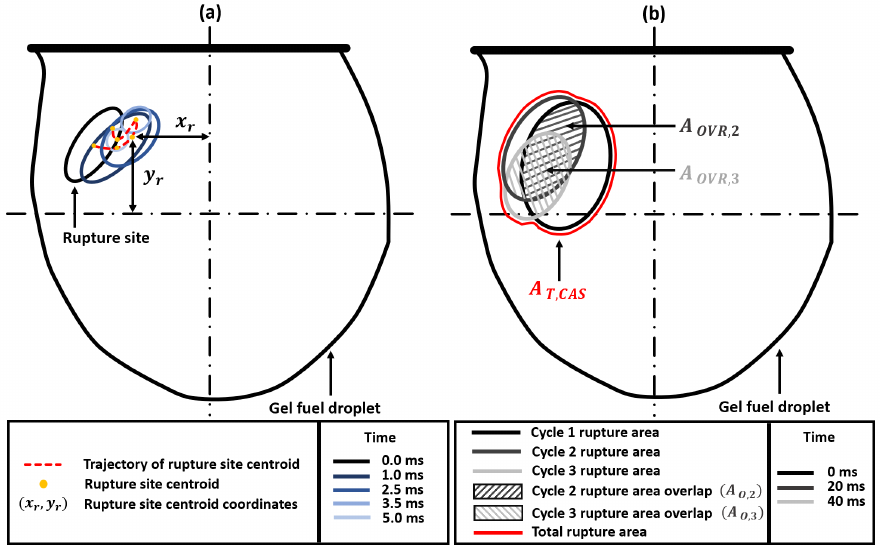
Figure 4. Schematic diagram showing the key geometrical parameters for analyzing the temporal evolution of the gellant shell. ( a ) Spatial movement of the rupture site centroid ( x r , y r ) during a single rupture–recovery cycle for a representative case. ( b ) The maximum rupture area of each cycle, with the rupture area overlapping between successive cycles ( A O ,2 and A O ,3 ), and the total rupture area for the cascade ( A T , CAS